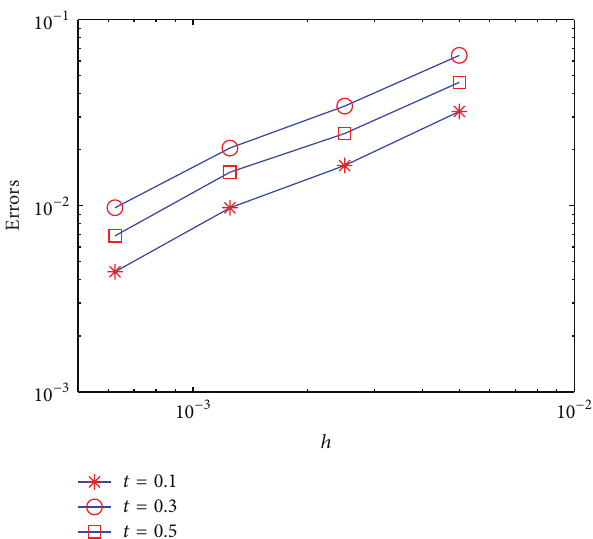
Figure4:TheerrorsfromTable 1plottedagainst ℎ onalog-logscale.